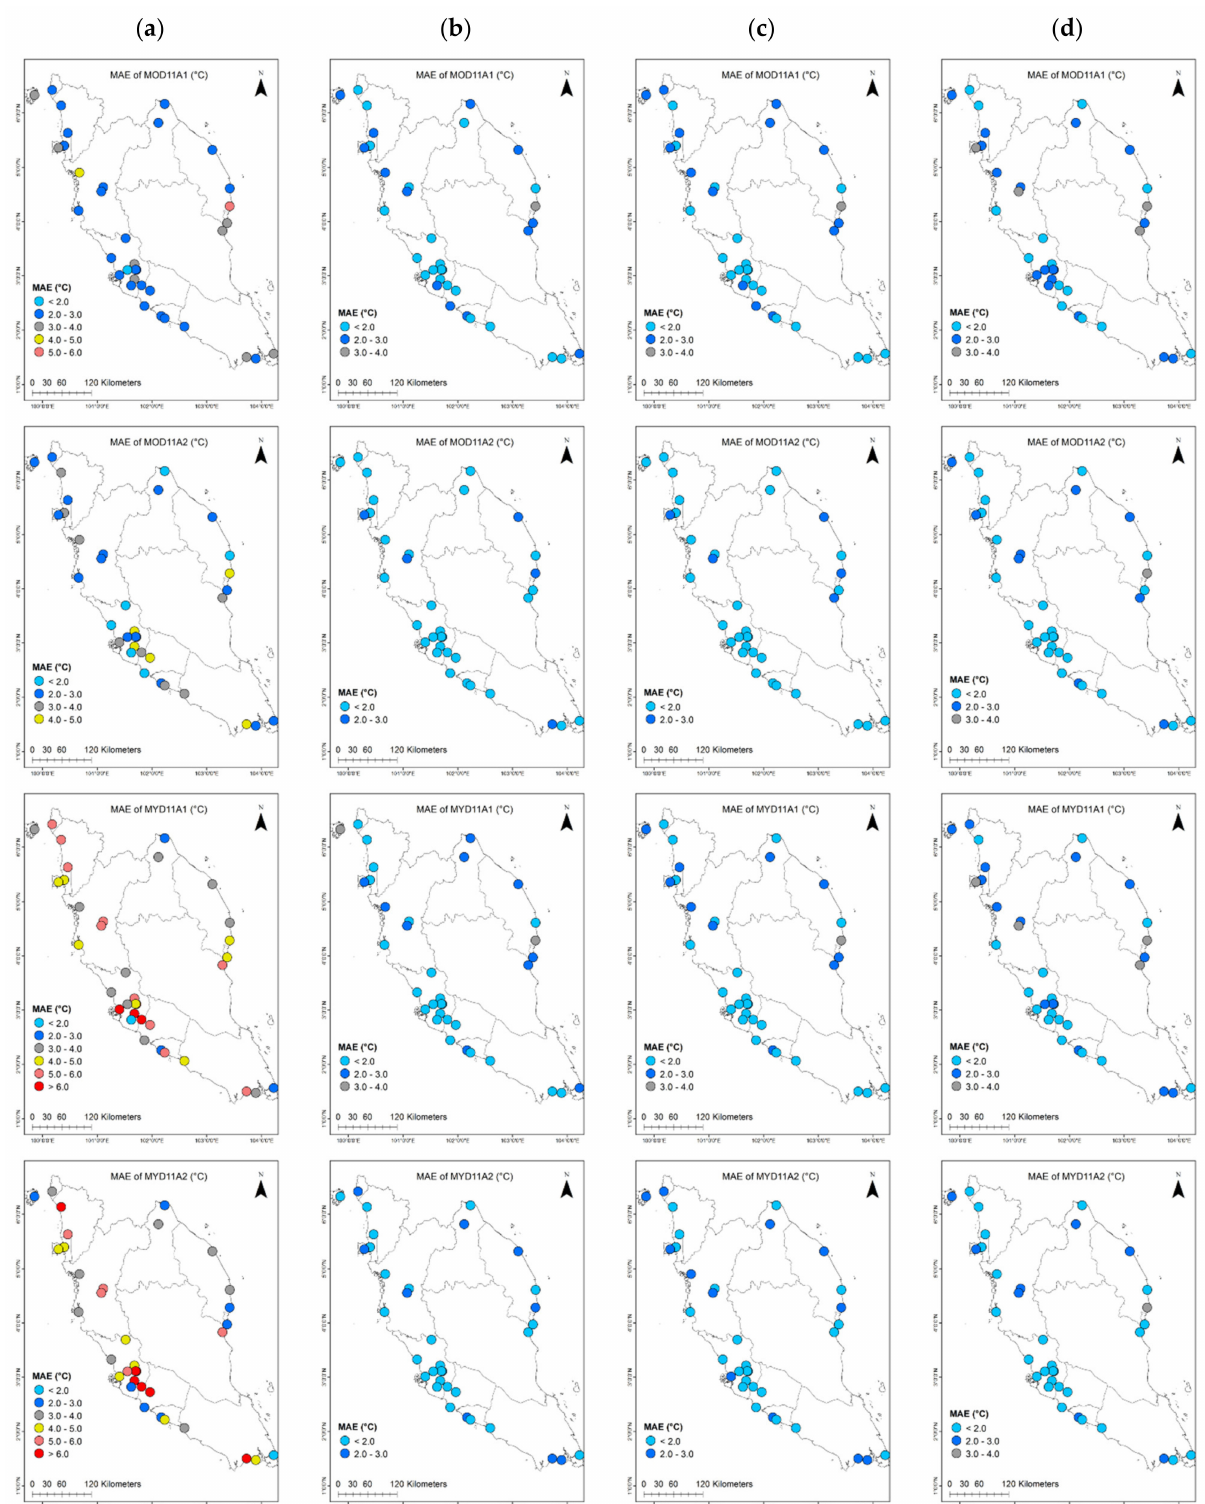
Figure 8. Distribution of MAE for comparison between simulated data, ( a ) T s , ( b ) T scd , ( c ) T scm , and ( d ) T scq , and observed data, T a . In contrast, the MAE distribution for post-MBC (T scd , T scm , and T scq ), as illustrated in Figure 8, revealed consistent low MAE values for all products, i.e., T scd = 1.19 to 3.15 ◦ C, T scm = 1.12 to 3.17 ◦ C, and T scq = 0.97 to 3.71 ◦ C. The majority of the stations for all